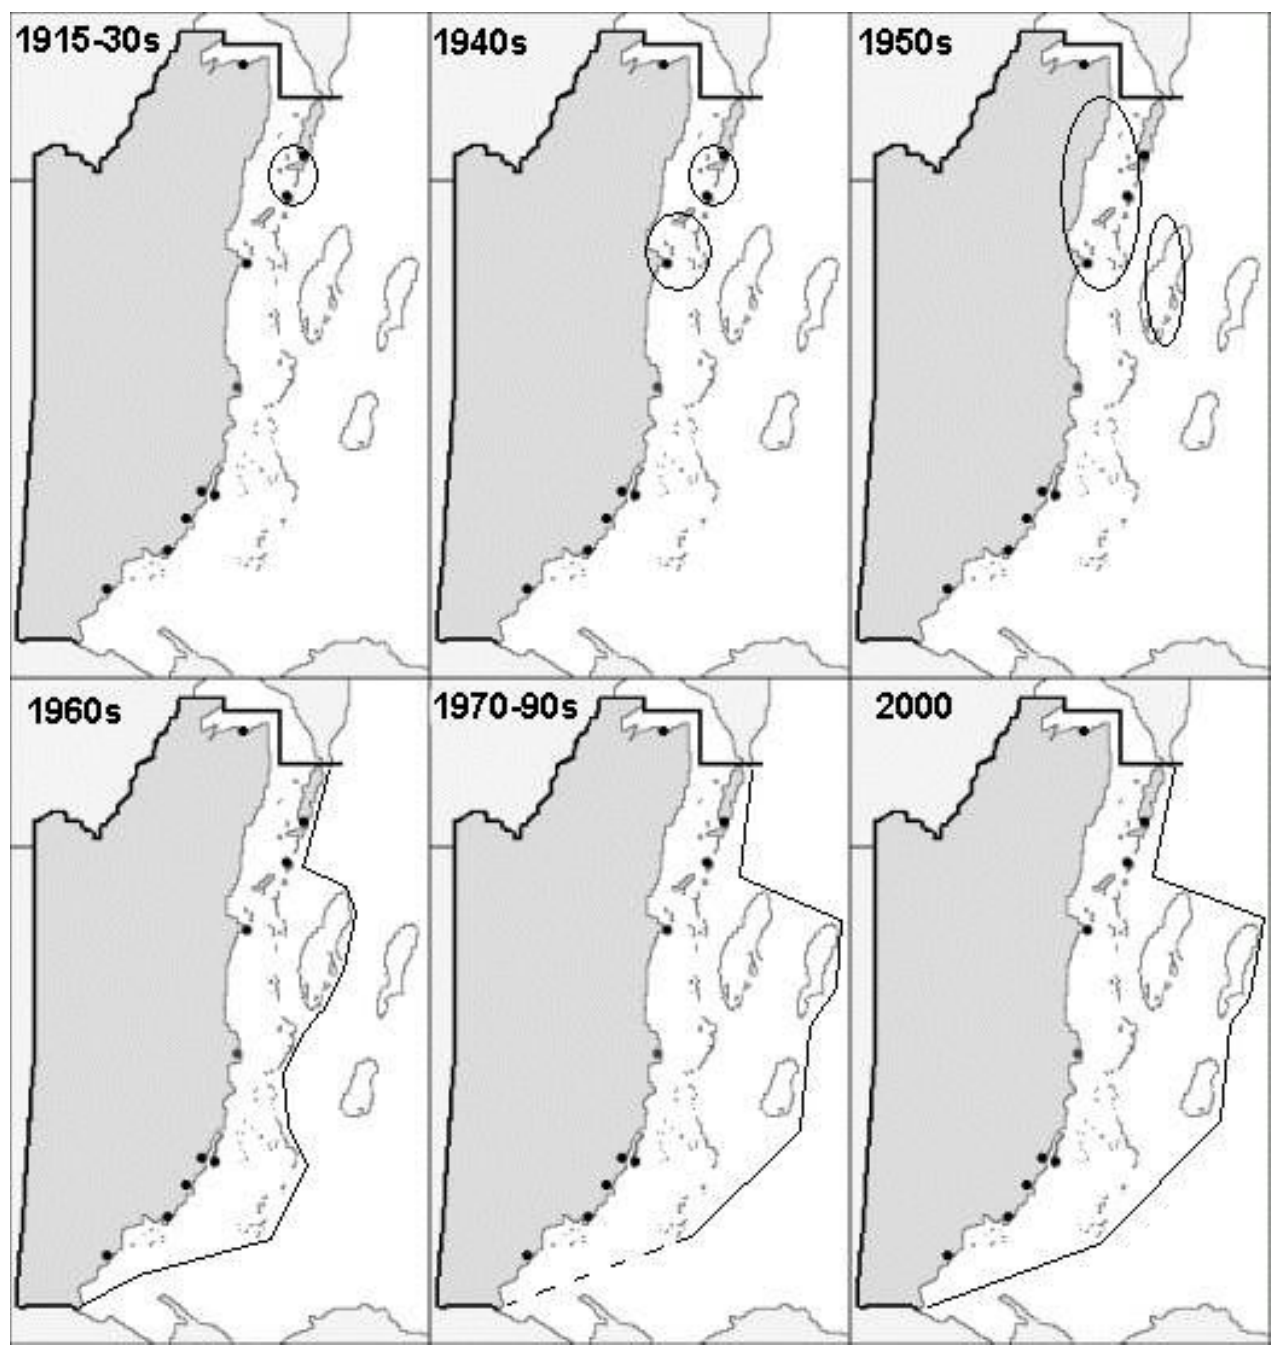
Fig. 3. Sequential exploitation of the fishing grounds over